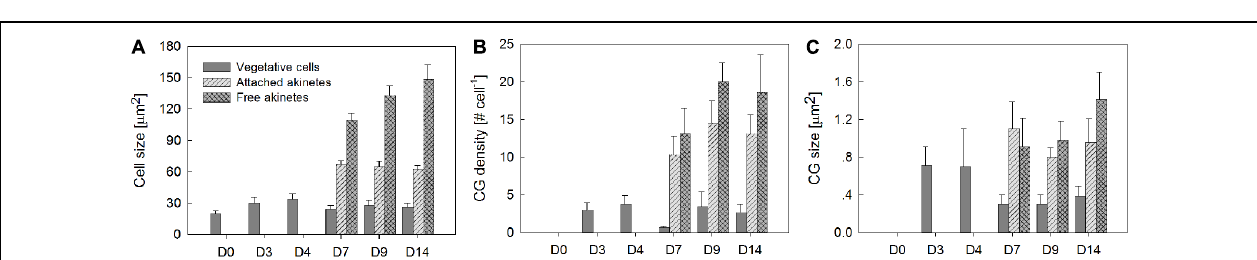
FIGURE 2 | Accumulation of cyanophycin globules (CG) in vegetative cells and akinetes in A. ovalisporum incubated under akinete-inducing conditions. Samples collected at different times during the induction (D0, D4, D7, D9, and D14, represent sampling days) were stained by Sakaguchi reaction and CG became dark visible. Filament-attached akinetes of different developmental stages are visible in D7, D9 and D14 (upper row) together with free akinetes (lower row). Scale bars represent 10 μ m.